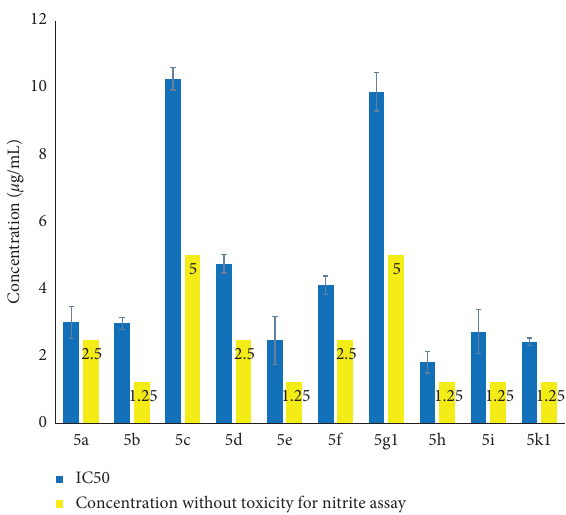
Figure 3: Inhibitory concentrations of test compounds on the viability of RAW264.7 macrophages. Table 1: Nitric oxide inhibitory activity of test compounds on RAW 264.7 macrophages.